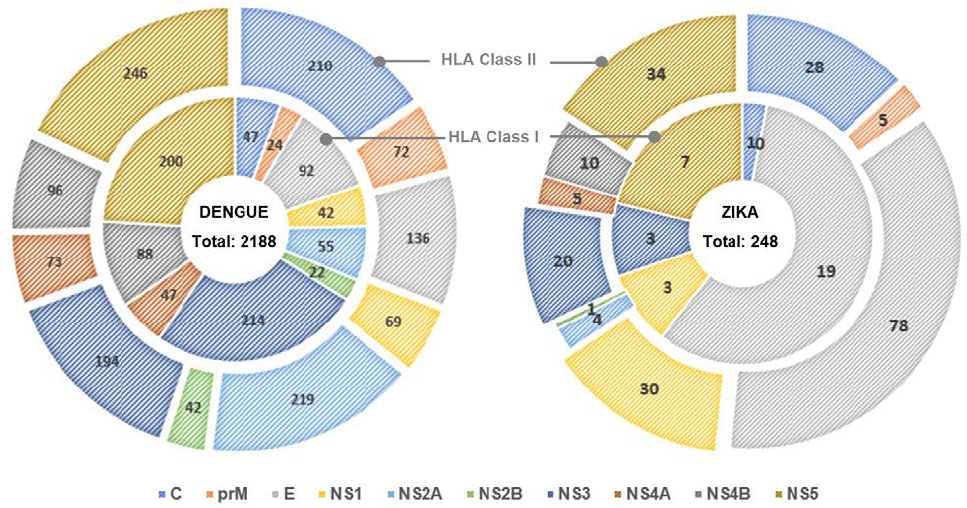
Figure 2. Number of immunodominant T cell epitopes against dengue (DENV) and Zika viruses (ZIKV). Data were retrieved from the IEDB (on 30th November 2021) corresponding to the HLA restriction (HLA class I: inner circle, HLA II: outer circle) and protein region.